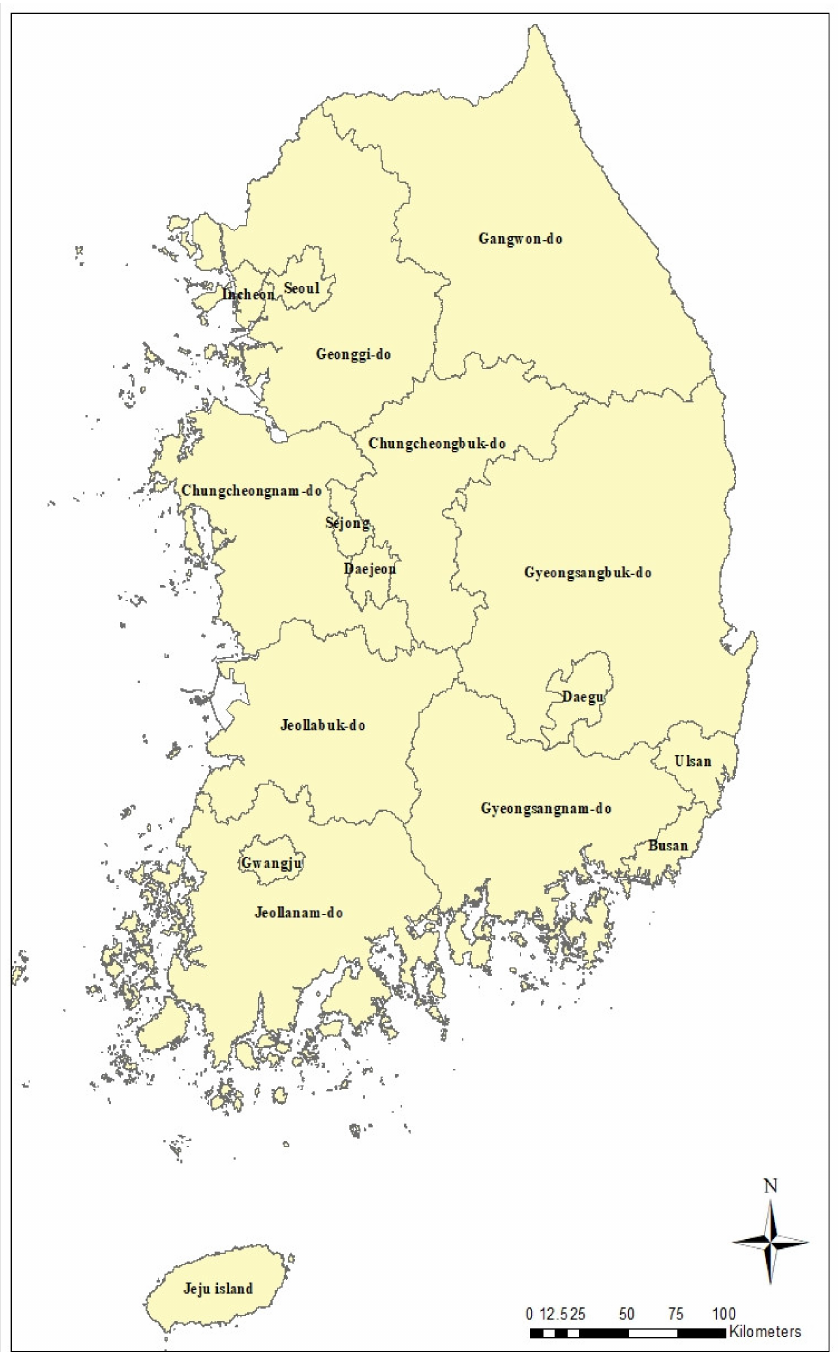
Figure 1. Spatial extent of the